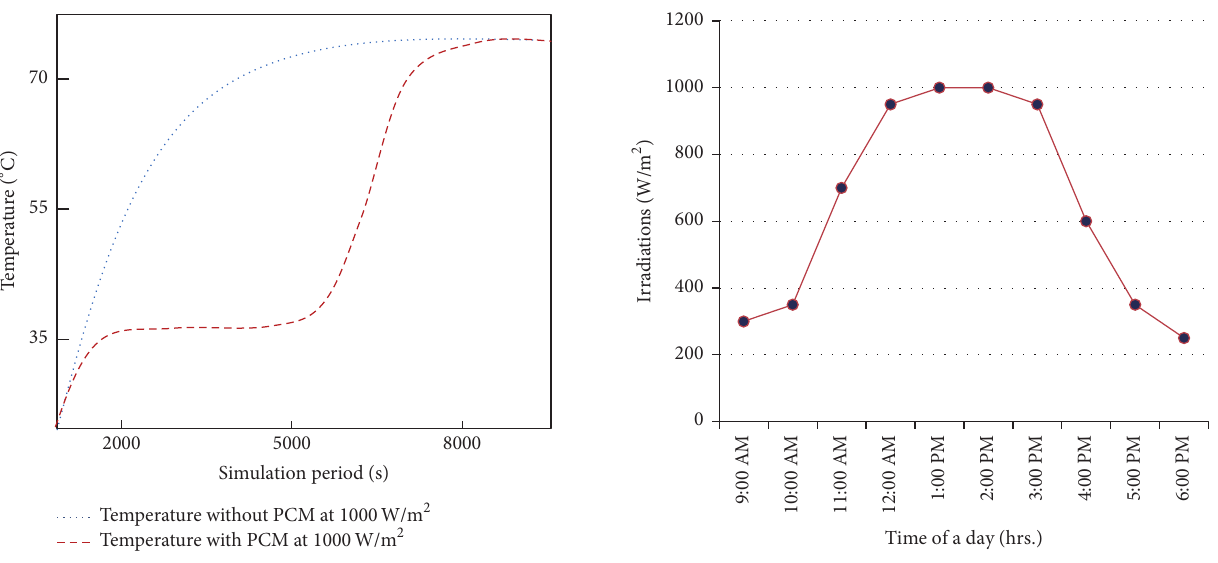
Figure 5: Temperature of PV module with PCM and without PCM at 1000 W/m 2 .